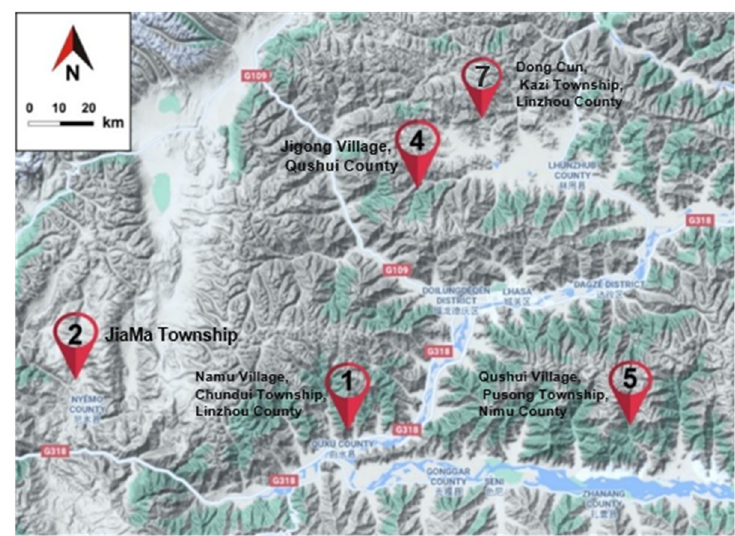
Figure 1. Location of tailings from typical metal mining areas and sampling sites in Tibet Autonomous Region (Sampling point 1 is iron ore tailings; Sampling point 2 is copper mine tailings; Sampling point 4 is molybdenum mine tailings; Sampling point 5 is gold mine tailings; Sampling point 7 is lead-zinc mine tailings). Table 1. Sampling situation of typical metal tailing pond in Tibet Autonomous